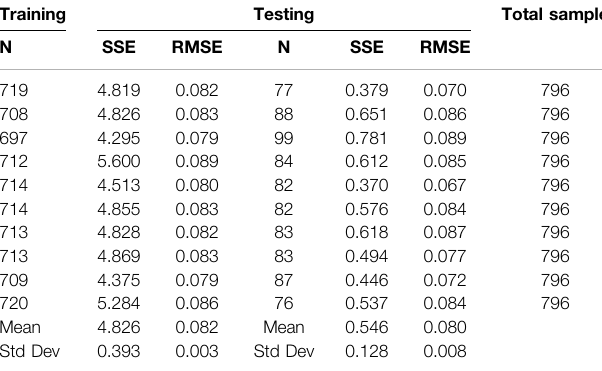
TABLE 6 | RMSE values for training and testing.